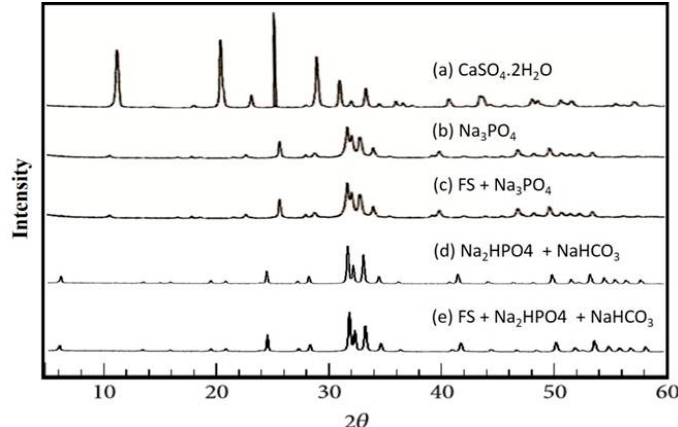
Figure 3. Powder XRD patterns of (a) preset gypsum before treatment; (b) preset gypsum after